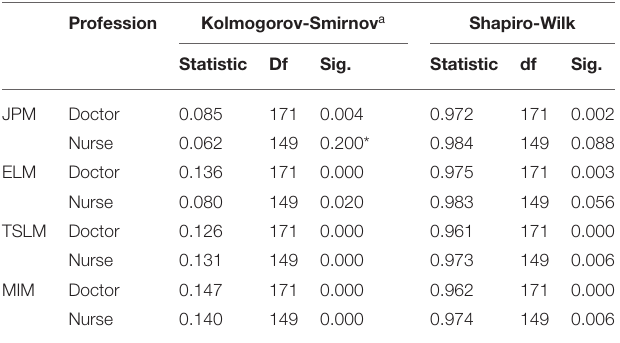
TABLE 3 | Tests of normality.